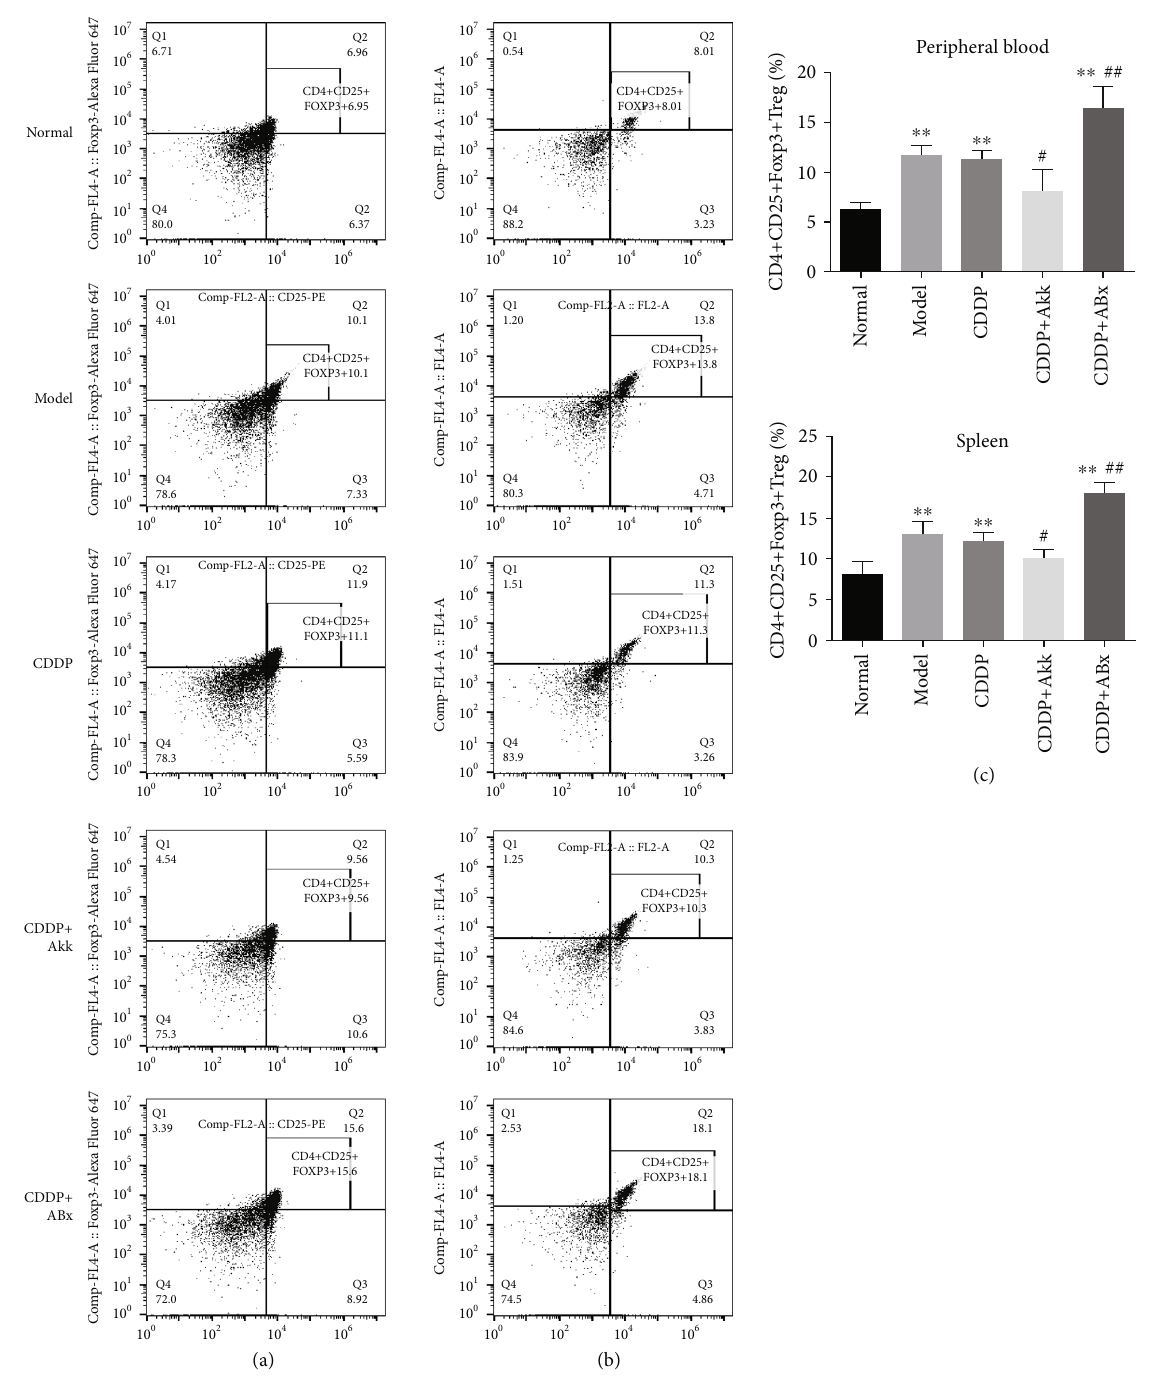
Figure 7: E ff ect of CDDP combined with Akk on ratio of CD4 + CD25 + Foxp3 + Treg cells in lung cancer mice. The ratio of CD4 + CD25 + Foxp3 + Treg cells in mouse peripheral blood (a) and spleen (b) mononuclear cells was measured by fl ow cytometry, quanti fi ed, and plotted in (c). Data were presented as the mean ± SD , n = 6 in each group, ∗ P < 0 : 05 , ∗∗ P < 0 : 01 versus the normal group; # P < 0 : 05 , ## P < 0 : 01 versus the CDDP